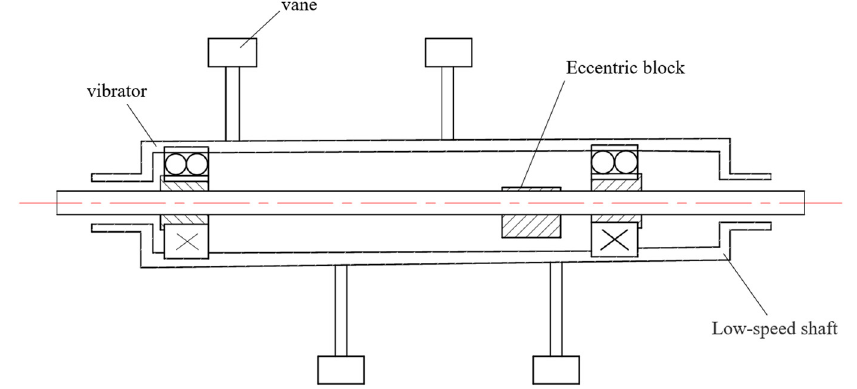
Figure 4: Diagram of mixer.